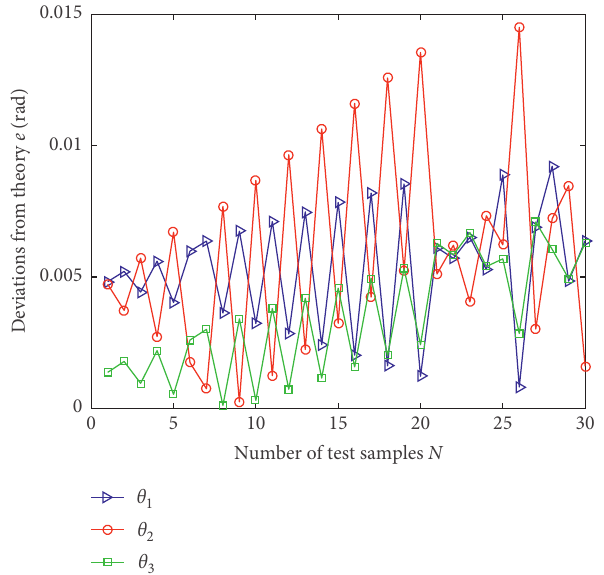
Figure 7: Absolute error of joint angles θ